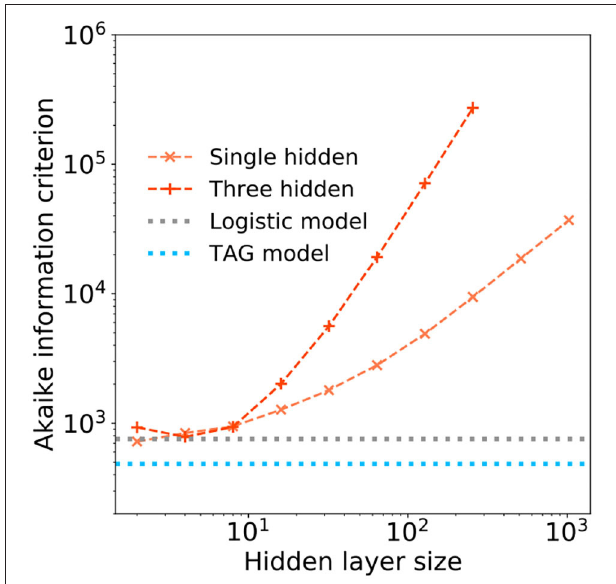
FIGURE 8 | The Akaike information criterion (AIC) is plotted in log-log scale over range of hidden layer width for (orange) a single hidden layer and (peach) a three hidden layer deep learning models. Horizontal dashed lines show the AICs of a (gray) logistic regression model and (blue) the TAG model.